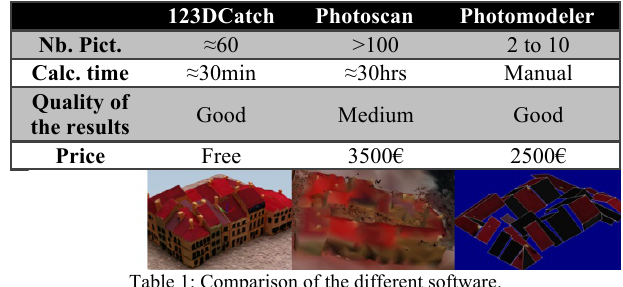
Table 1: Comparison of the different software.